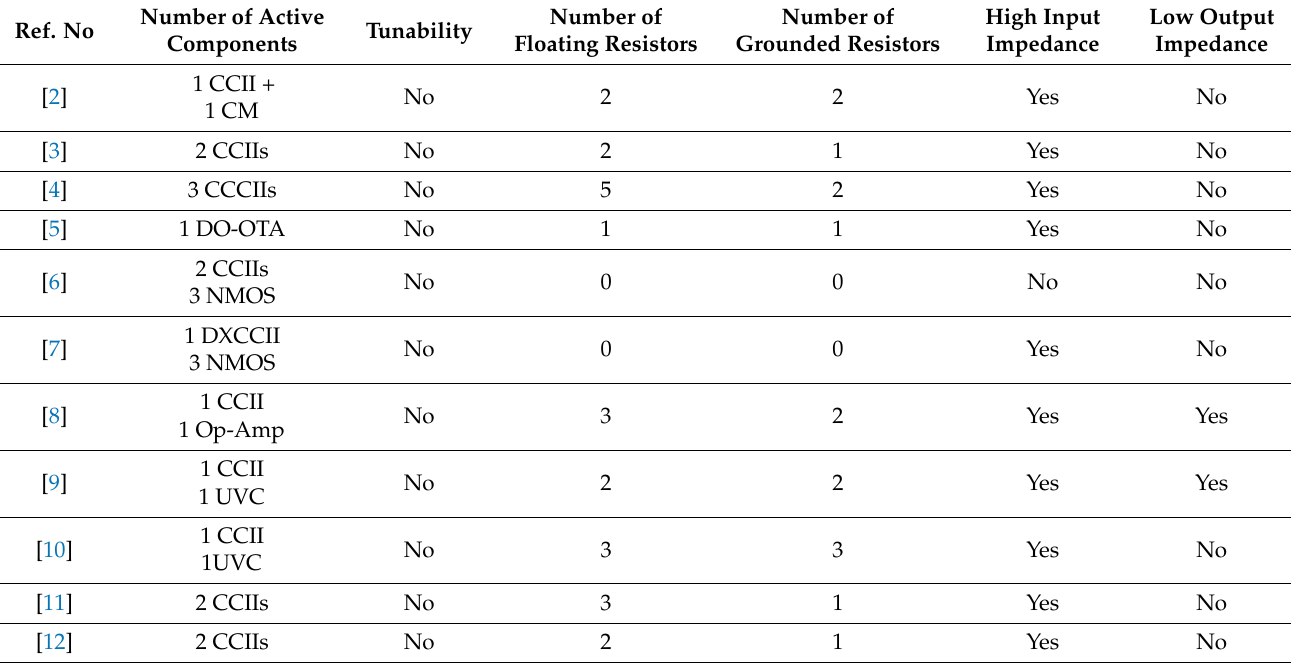
Table 2. Comparison of proposed rectifier circuit with existing